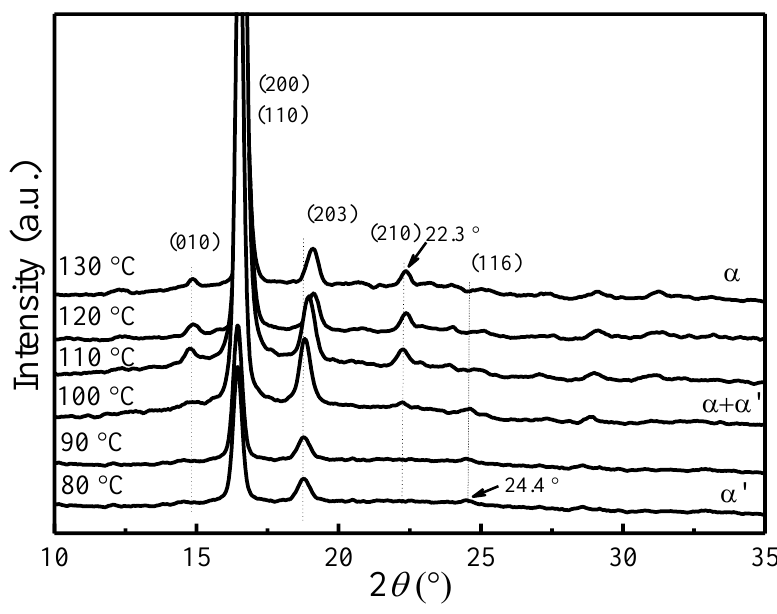
Figure 1. XRD diffraction patterns of PLLA samples melt-crystallized at different T c .